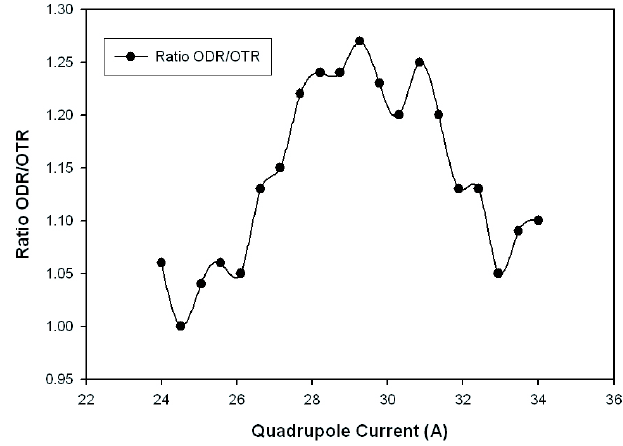
FIG. 10. The ratio of ODR = OTR horizontal image sizes for different beam sizes during the AQ2 quadrupole scan. This ratio is noticeably smaller than for unpolarized data reported earlier.